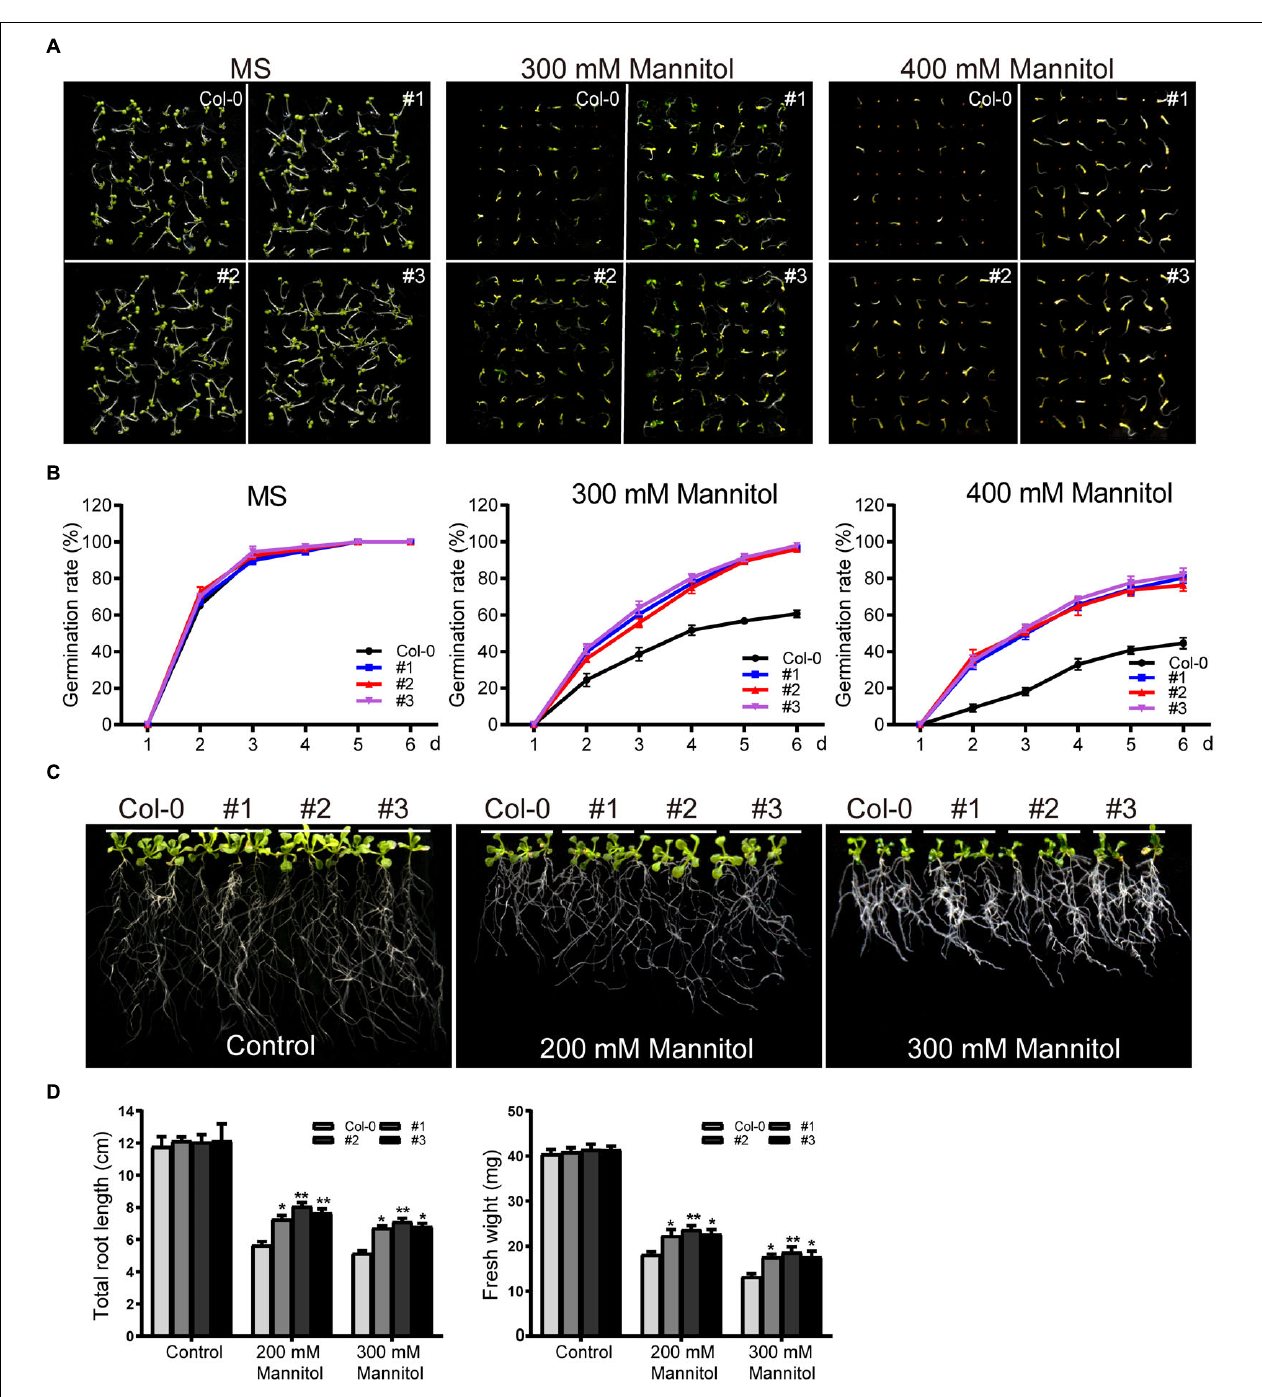
FIGURE 9 | Phenotype analysis of TaDEAD-box57-3B transgenic plants under dehydration treatment. (A) Seed germination assays of WT and TaDEAD-box57-3B transgenic lines. Seeds were grown on MS and MS medium supplemented with 300 mM and 400 mM mannitol. (B) The germination rates of WT and TaDEAD-box57-3B transgenic lines. The germination rate was calculated for the next 6 days. (C) Root length assays of WT and TaDEAD-box57-3B transgenic lines. Five-day-old seedlings were transferred to MS medium with or without 200 mM, 300 mM mannitol. (D) The total root lengths and fresh weights of WT and TaDEAD-box57-3B transgenic lines. All the data represent the means ± SDs of three independent biological replicates and asterisks (*or **) represent the significant differences at p < 0.05 or p < 0.01(ANOVA test).